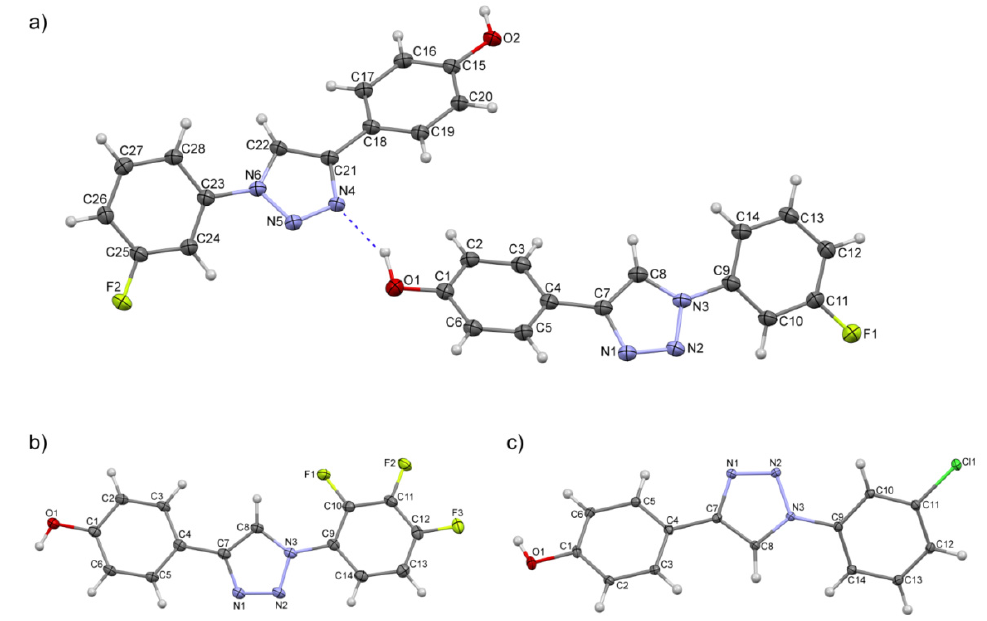
Figure 2. Molecular structures of ( a ) 6a ; ( b ) 6c ; ( c ) 6d . Thermal ellipsoids at 50%.